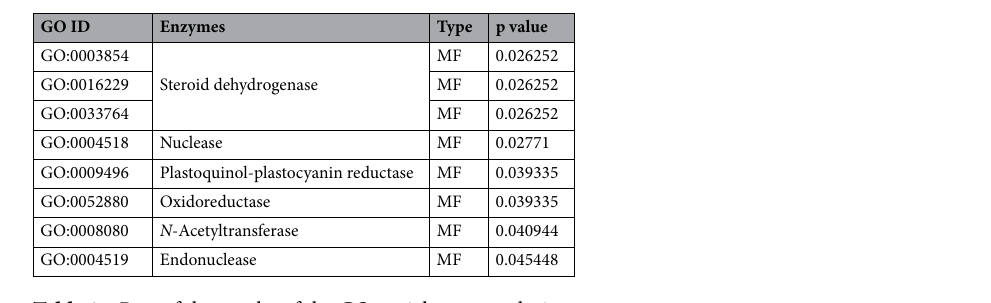
Table 3. Part of the results of the GO enrichment